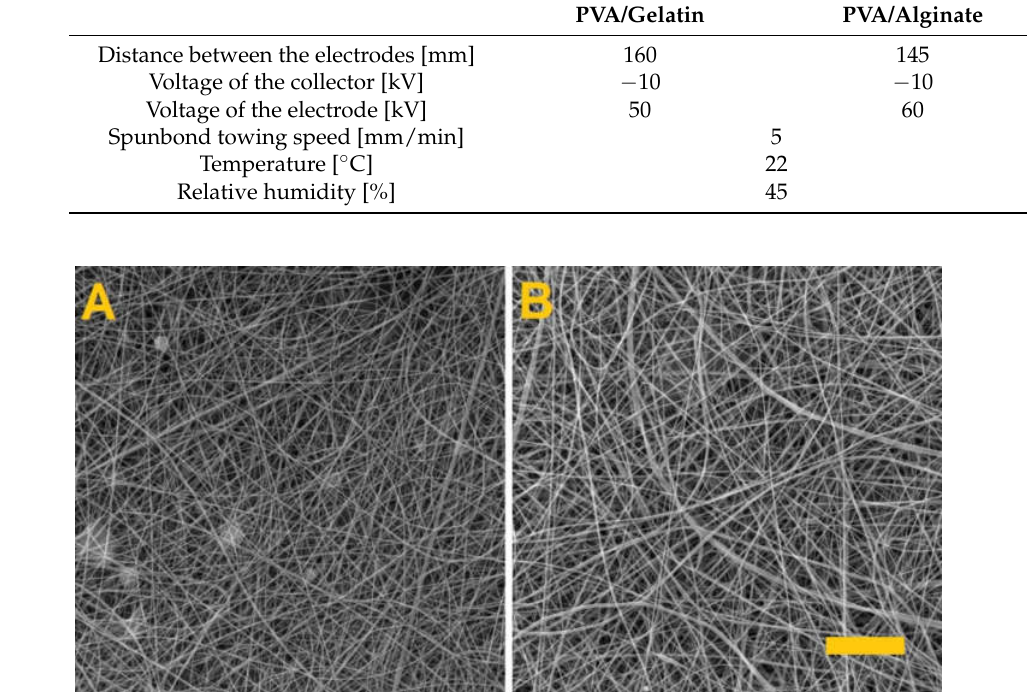
Table 1. Process parameters of the spinning of the selected solutions.